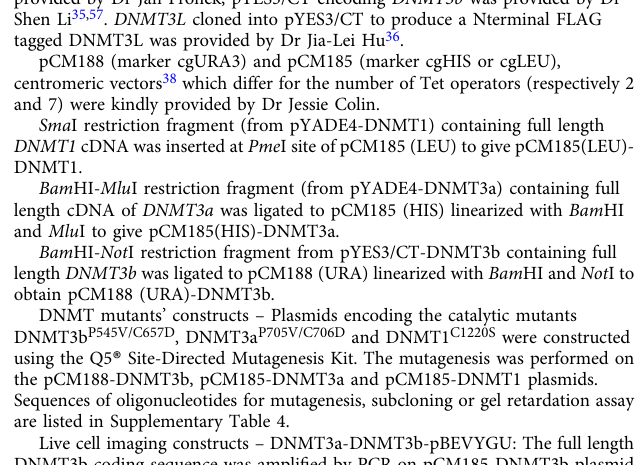
Fig. 6 Effect of DNA methylation on 3D genome structure. Differential contact frequencies in control and methylation-induced samples in replica 1 for ( a ) whole genome and ( b ) four chromosomes. Blue indicates interactions with a higher frequency in the non-methylated control samples compared to the methylated samples, while red indicates the converse. c Comparison of contact frequencies between control and methylated Hi-C samples in cis (±50 Kb from the centromere, top panel) and in trans (lower panel). Contact frequencies for n = 16 chromosomes on two biological replicas for each of the two conditions. Boxplot lower and upper hinges correspond to the fi rst and third quartiles, respectively, and the middle line represents the median. The upper and lower whiskers extend from the hinge to the largest and smallest values, respectively, but no further than 1.5 × IQR (Inter-quartile range) from the hinge. Notches extend to ±1.58 IQR/sqrt(n) and give a rough 95% con fi dence interval for the median. Circos plots displaying the signi fi cant (FDR < 0.5) differential interactions identi fi ed with diffHiC: d gained interactions (log2FC > 1) are clustered around the centromeres (red tick marks) and e lost interactions (log2FC < − 1) preferentially occur between chromosomes. Structural changes measured on the ensemble of structures obtained with our restraint-based 3D model for each chromosome: f Mean radius of gyration computed around centromeres (±100kb) and g fl exibility of each chromosome measured by the RMSD of bead positions for the control (black) and methylated (red) samples. Values ± standard error are plotted ( N = 260 and 482 ensemble structures for control and methylated samples, respectively). h Relative distance (distance divided by mean) between all telomeres in the ensemble of 3D structures ( n = 496,000 distances). Outliers were not plotted (min/median/max values are 0.081/0.920/1.901 for control and 0.099/ 1.080/1.919 for methylated conditions). The p value is from a two-sided t -test for the difference in means. i Whole-genome 3D model for a representative structure from the ensemble for the control (Left) and methylated sample (Right). All chromosomes are represented as gray tubes, and the telomeres represented as colored spheres with a different color for